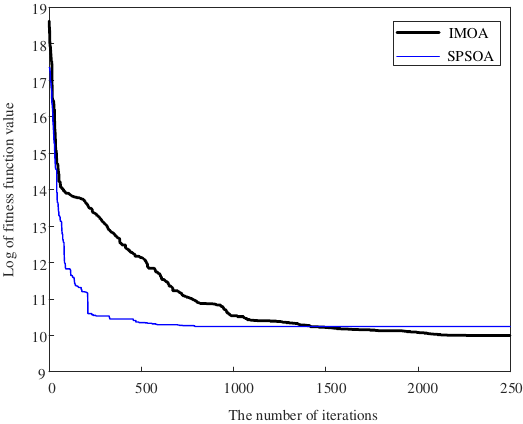
Figure 8. The descent process of the fitness function value. Table 3. Compensation parameters values estimated using the two methods.